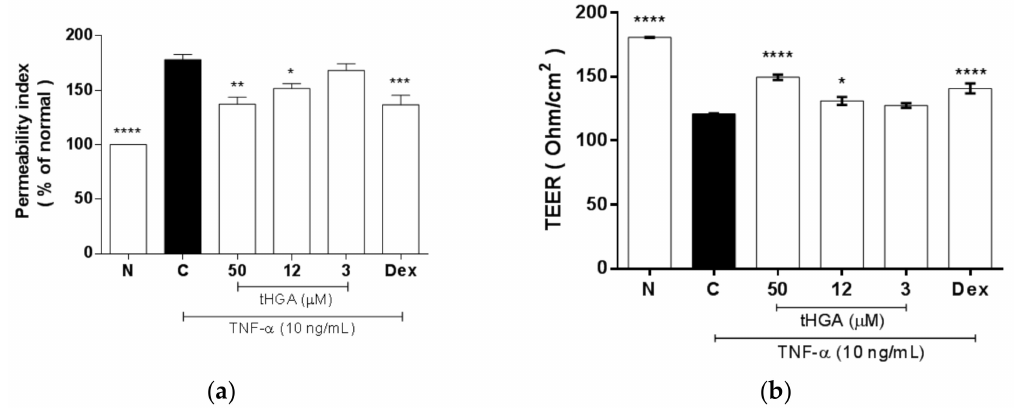
Figure 4. The effects of tHGA on epithelial permeability in response to TNF- α induction in A549 monolayer. ( a ) Fluorescein isothiocyanate (FITC)-dextran fluxes across A549 monolayers. Confluent A549 cells were induced with 10 ng/mL TNF- α and treated with indicated concentrations of tHGA or positive control for 24 h in poly- L -lysine coated cell culture insert. The extent of permeability was measured by fluorescence intensity of the samples collected from basolateral compartment, as described in Methods. ( b ) Transepithelial electrical resistance (TEER) measurement at 3 h post-induction and indicated treatments. A549 cells were seeded onto Transwell inserts and cultured in air-liquid interface for 5 days, followed by induction with 10 ng/mL TNF- α and co-treatment with indicated concentrations of tHGA for 24 h. TEER was monitored for 3 h post induction as described in Methods. All values are expressed as mean ± SEM of at least three independent experiments, where * p ≤ 0.05, ** p ≤ 0.01, *** p ≤ 0.001 and **** p ≤ 0.0001 versus TNF- α -induced cells, according